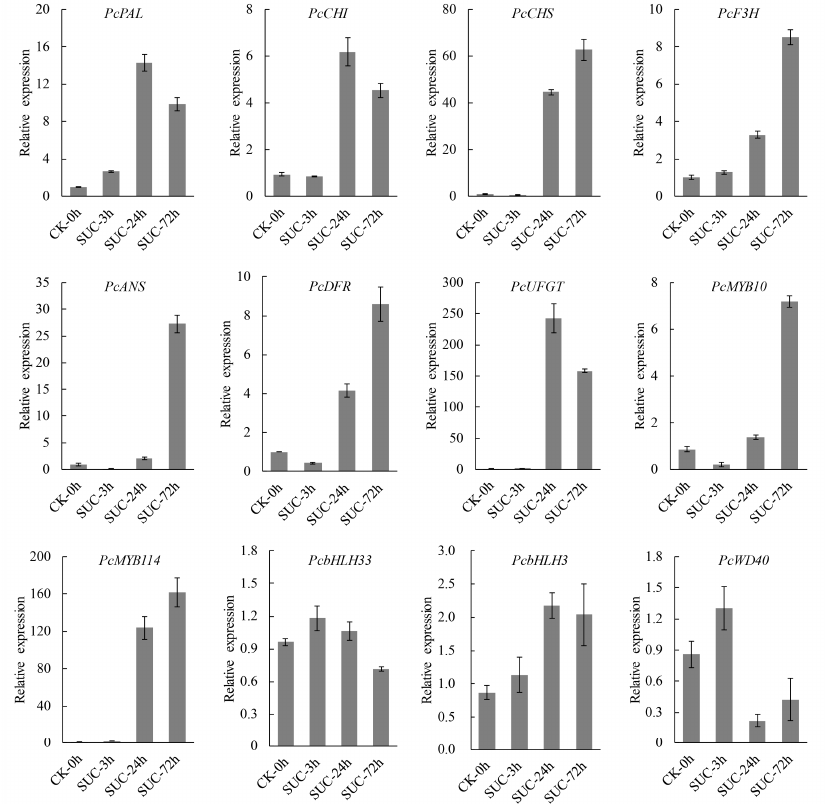
Figure 10. RT-qPCR analysis of anthocyanin biosynthesis-related structural and regulatory genes under sucrose treatment. Error bars indicate the mean ± SD of three independent